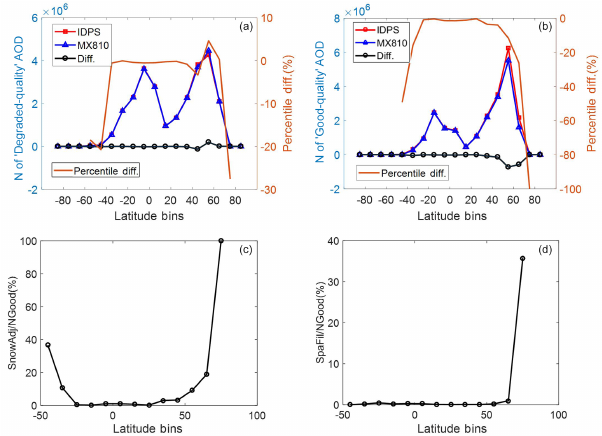
Figure 5. Statistics in the sample size and percentage change in the AOD retrievals on 18 May 2014 as a function of 10 ◦ latitude bin: (a) number of “degraded”-quality AOD retrievals, produced by the algorithm running the old VRA-based snow mask (red line with squares) and the new NDSI-based snow mask (blue line with tri- angles), and the difference between the two (black line with open circles). The brownish-red line displays the difference as a percent- age that is read along the right-hand axis. (b) Same as (a) but for “good”-quality AOD retrievals only; (c) the percentage of the pixels flagged as adjacent to an identified snow pixel over the total number of “good”-quality AOD IP retrievals; and (d) the percentage of the pixels flagged by the homogeneity test (spatial filter) over the total number of “good”-quality AOD retrievals.